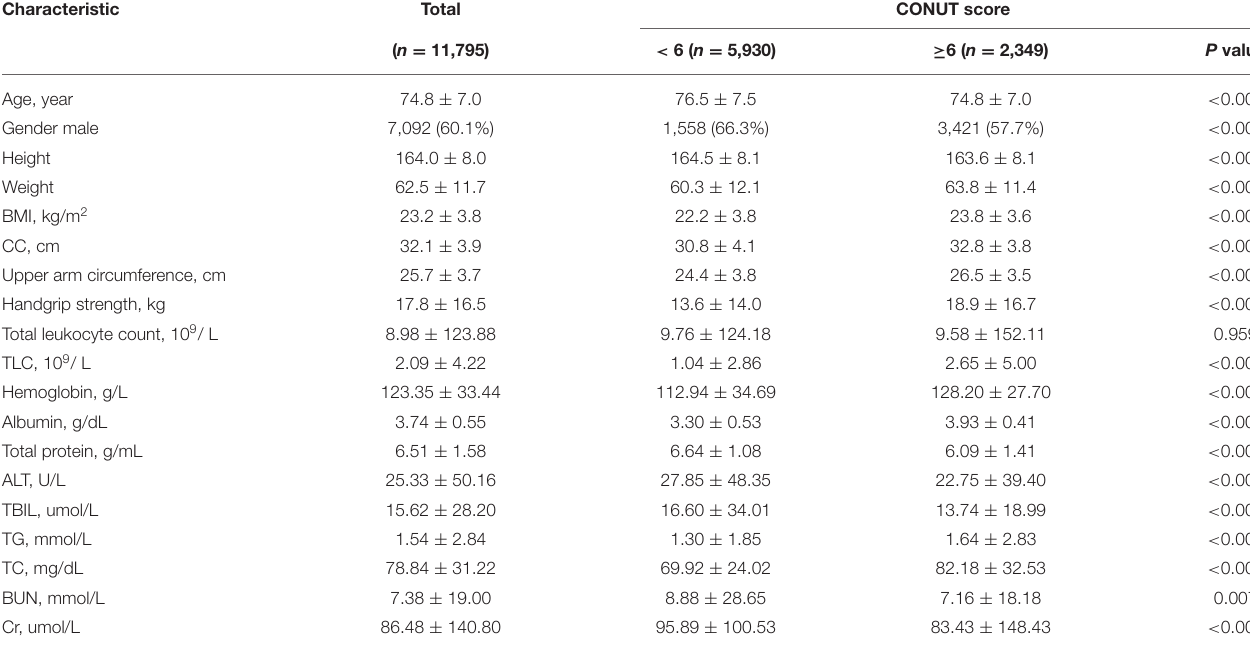
TABLE 1 | Demographic and clinical characteristics of older adult patients. Characteristic